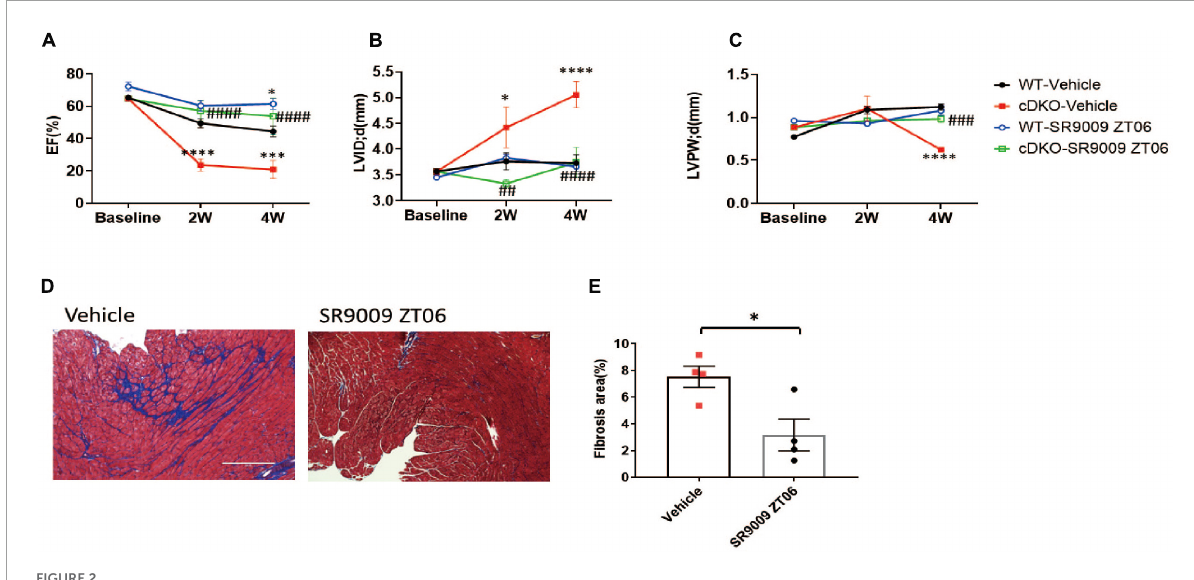
FIGURE2 SR9009 rescues post-TAC cardiac dysfunction in REV-ERB deficient mice. (A–C) Echocardiography of WT and cDKO after vehicle or SR9009 treatment at ZT06. WT-vehicle n = 10, cDKO-vehicle n = 5, WT-SR9009 n = 5, and cDKO-SR9009 n = 6. (D,E) Representative images and quantification of fibrosis area by Masson’s trichrome staining at 4 weeks after TAC for cDKO mice treated with SR9009 at ZT06. Data are shown as mean ± S.E.M. ## p < 0.01, ### P < 0.001, #### P < 0.0001, ∗ p < 0.05, ∗∗∗ p < 0.001, ∗∗∗∗ P < 0.0001 by two-way ANOVA, ∗ indicates comparison to WT-vehicle, # indicates comparison to cDKO-vehicle. Tukey’s test was used for multiple comparison